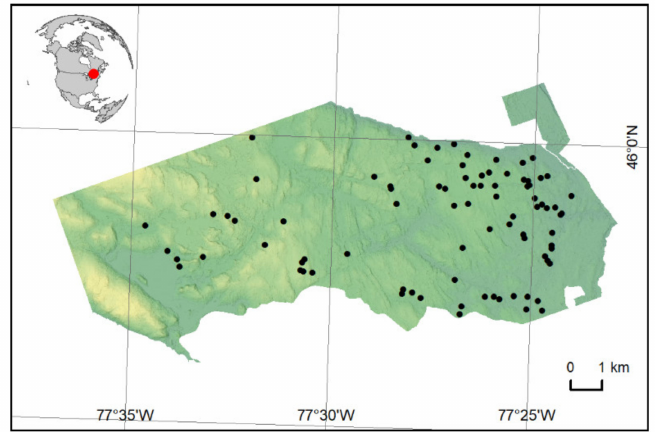
Figure 1. Relief map of the Petawawa Research Forest. Black markers indicate field plot